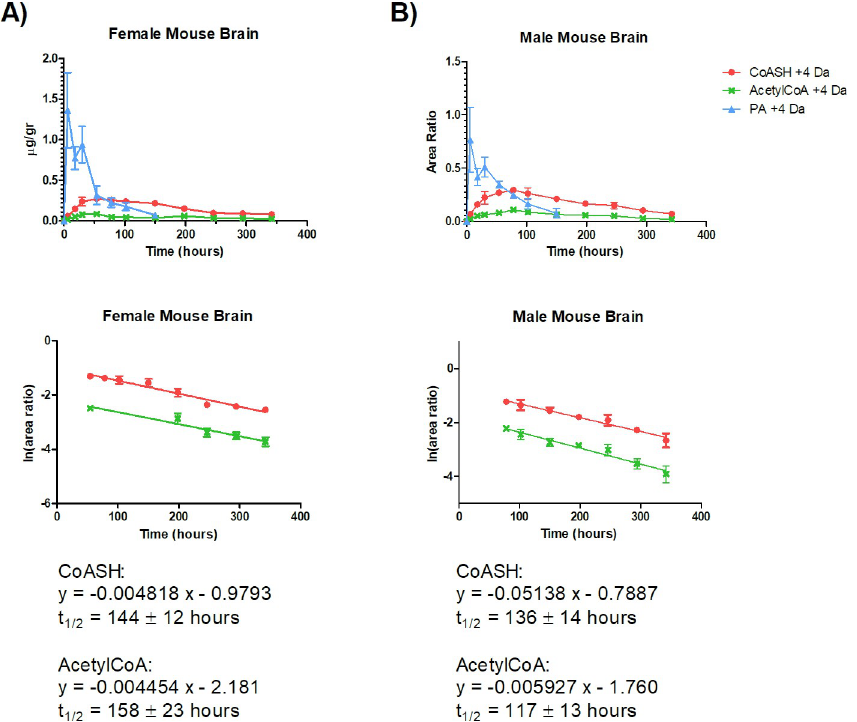
Fig 4. Half-life of free CoA (CoASH) and acetylCoA in A) female B) male mouse brain. C57BL/6N mice were kept for 3 days under a PA-free diet and then orally dosed with 25 mg/kg of [ 13 C 3 - 15 N]-PA. Brain samples were collected and analysed by LC-HRMS to determine the labelled (+4 AMU) and unlabelled CoASH and acetylCoA levels. The metabolite half-life was calculated from C max to the last time point collected. Error bars, mean ± SD for triplicate samples.